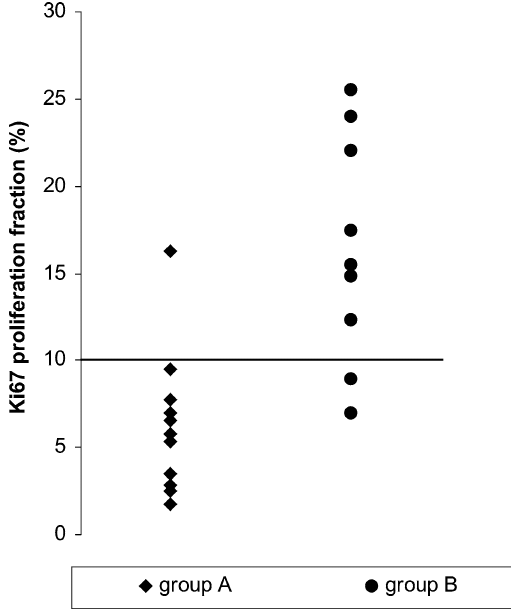
Fig. 1. Ki67 proliferation fraction (%) of reactive mesothelial cells in tumor cell negative effusions of patients without (A) and with a malignant disease (B) other than